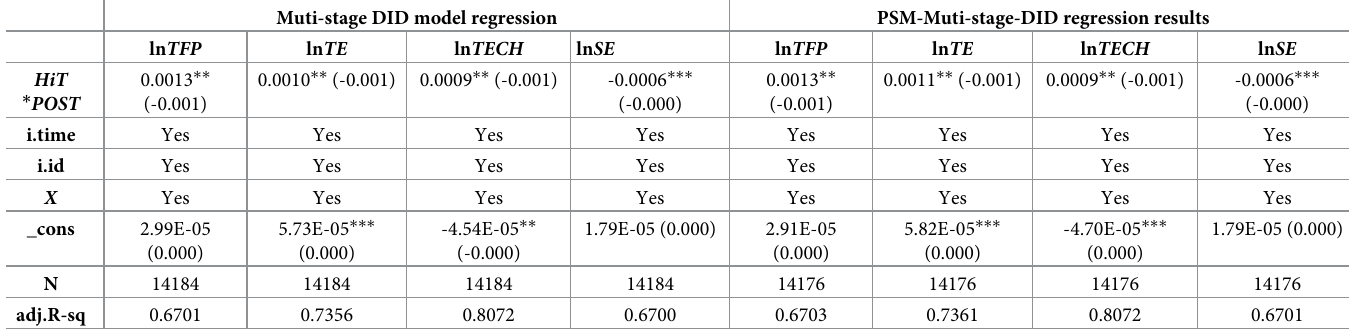
Table 2. OLS regression results and PSM-DID regression results for model